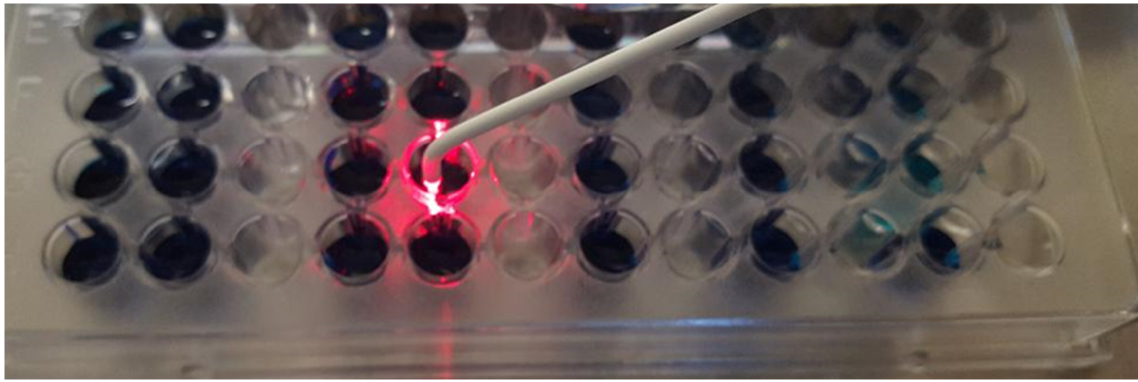
Figure 2. Application of photodisinfection treatment to A. actinomycetemcommitans .